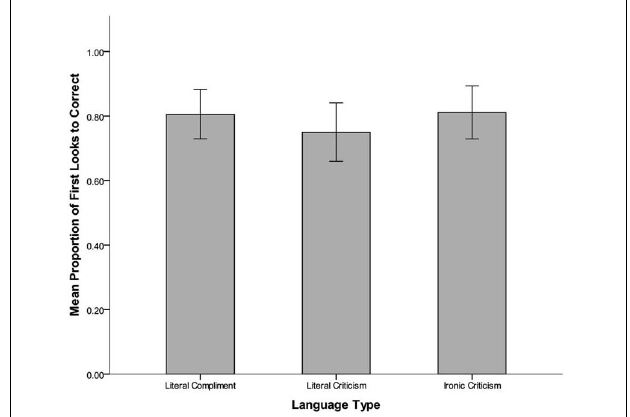
FIGURE 3 | Mean proportion of first looks to the correct object on correct trials. Bars represent standard error.